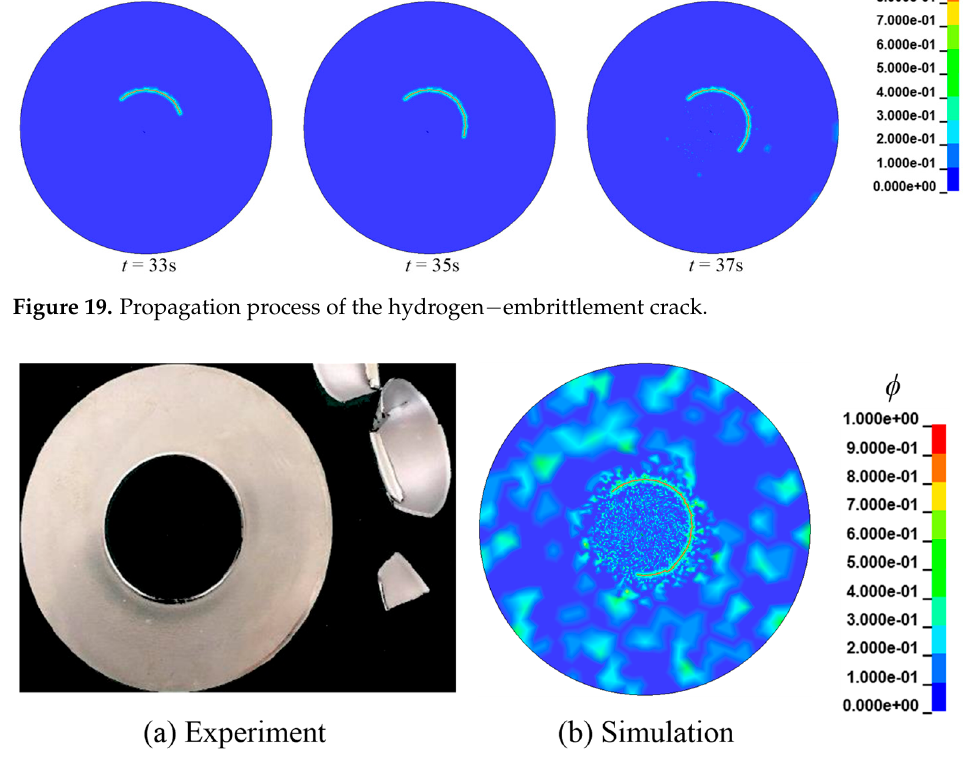
Figure 20. The final crack of the disk.